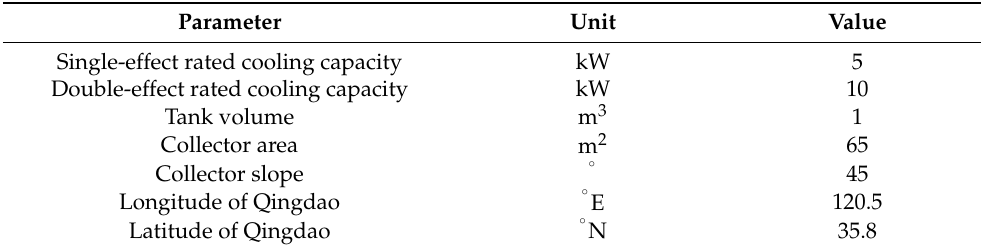
Table 2. Values for design parameters of the system.